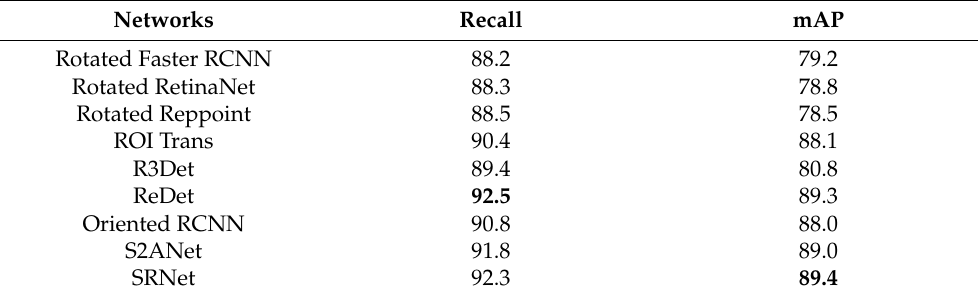
Table 2. Rotated object detection performance of different networks on the RSDD